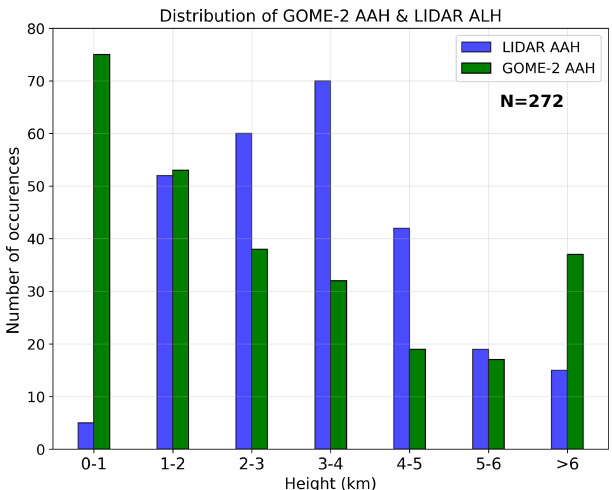
Figure 3. Bar plot of GOME-2 AAH (green) and EARLINET ALH (blue) stations. The height ranges of bins are between 0–1, 1–2, 2– 3, 3–4, 4–5, 5–6 and > 6km. The bar counts indicate the number of collocated